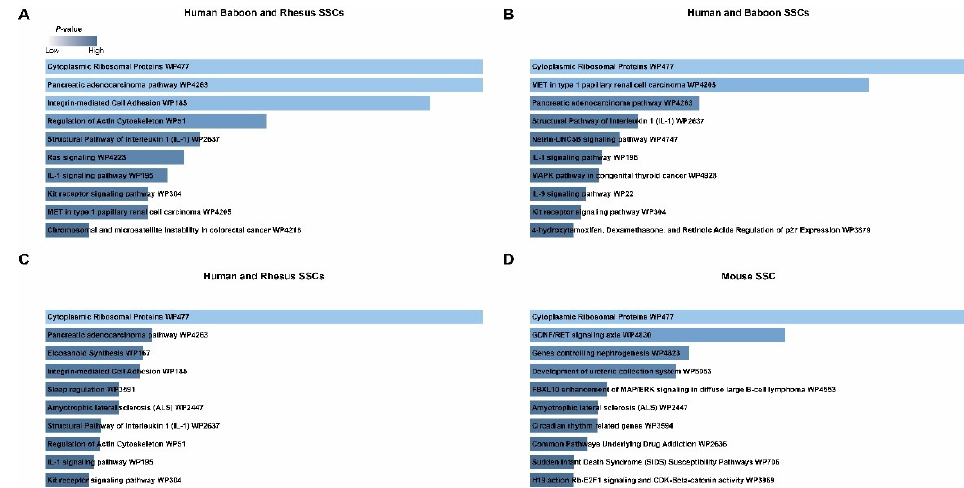
Figure 4. Pathways analyses reveal unique biological pathways among conserved primate SSC markers. Pathway analysis of the ( A ) 32 markers of human, baboon, and rhesus SSCs, ( B ) 105 markers of human and baboon SSCs, ( C ) 53 markers of human and rhesus SSCs, and ( D ) 127 markers of mouse SSCs. The lengths of the horizontal bars and their color represent p -values according to the scale.